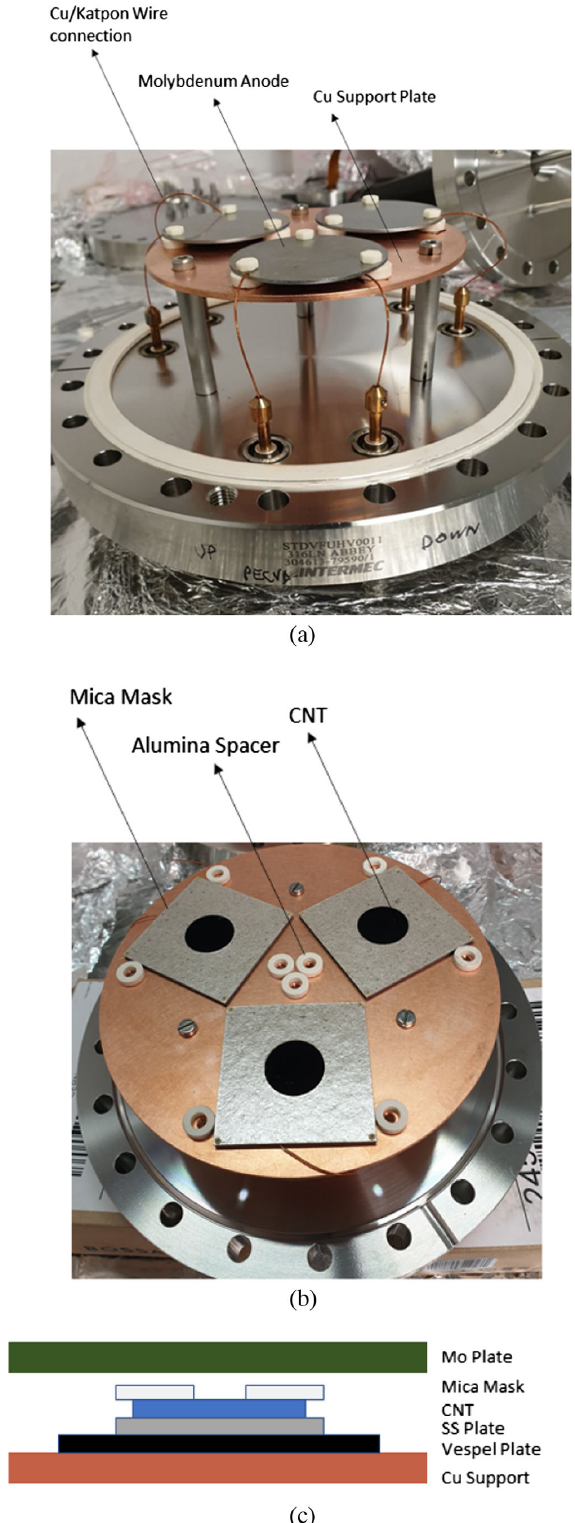
FIG. 2. (a) Cold cathode test bench. (b) Flange and CNT samples arrangement. (c) Sample stack